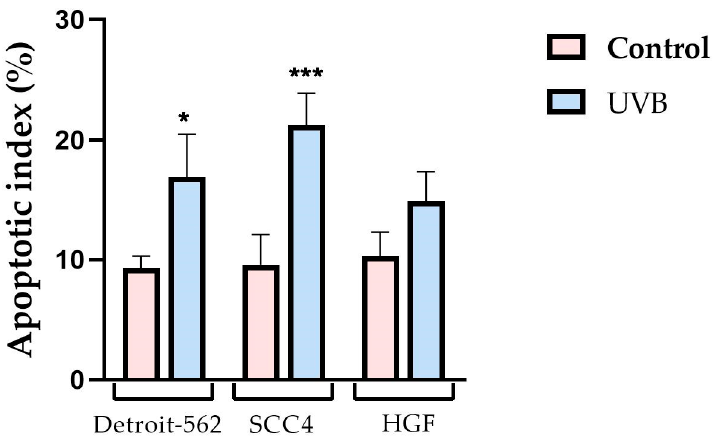
Figure 4. Analysis of the apoptotic index (AI) of Detroit-562, SCC4, and HGF, following exposure